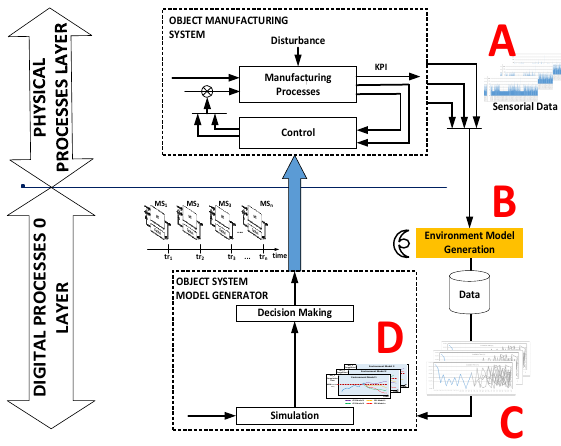
Figure 1. CPPS 0 logical architecture adapted from [24]